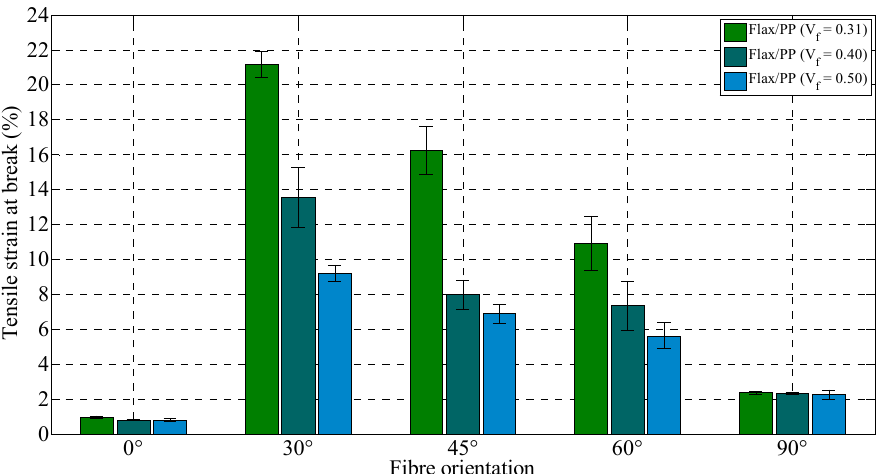
Figure 17. Tensile strain at break for flax/PP samples of different fibre volume fractions and orientations.